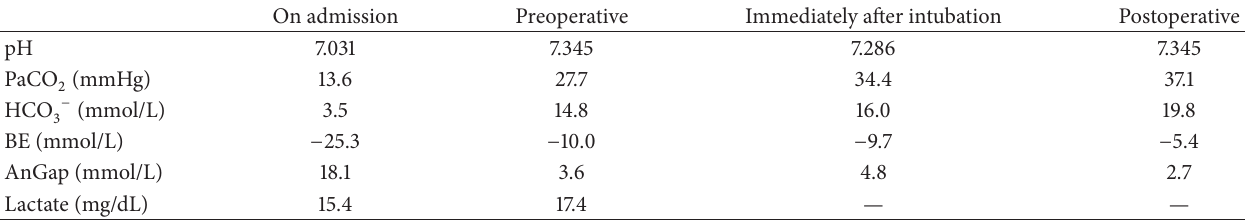
Table 1: Perioperative blood gas analysis.